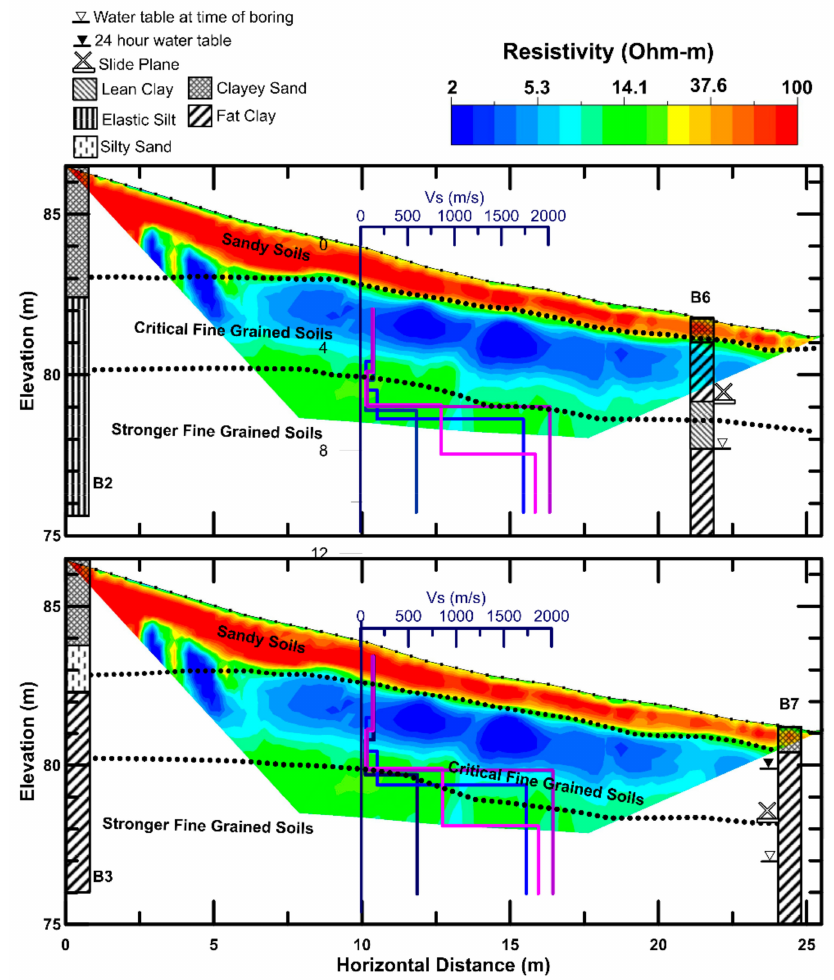
Figure 5. Inverted resistivity profile for line R2 compared to borings B2/B3 and B6/B7 with shear wave velocity ( V s ) profile from MASW line S1, boring information, and estimated slide plane location. (Note: the different seismic profiles shown in blue, dark blue, purple, and pink represent different dispersion curves selected for inversion of the measured MASW